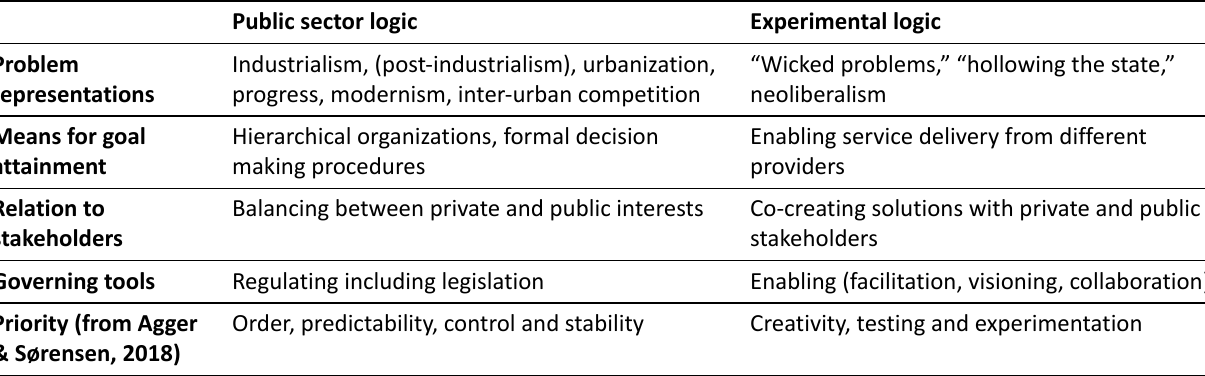
Table 1. Five points of negotiations in testbed